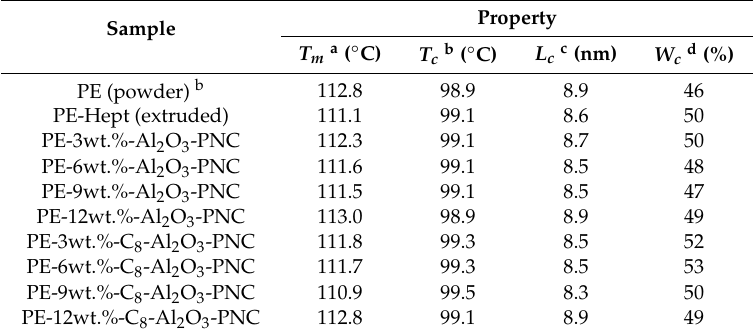
Table 1. Thermal characterization of the LDPE-based materials.